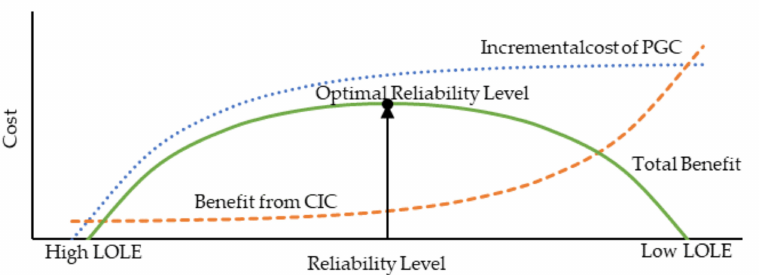
Figure 3. Concept of optimal reliability criteria determination from the total benefit of a power system. The CIC is calculated from the net present value of the multiplication of EENS and IEAR for every year in the generation planning period, as shown in